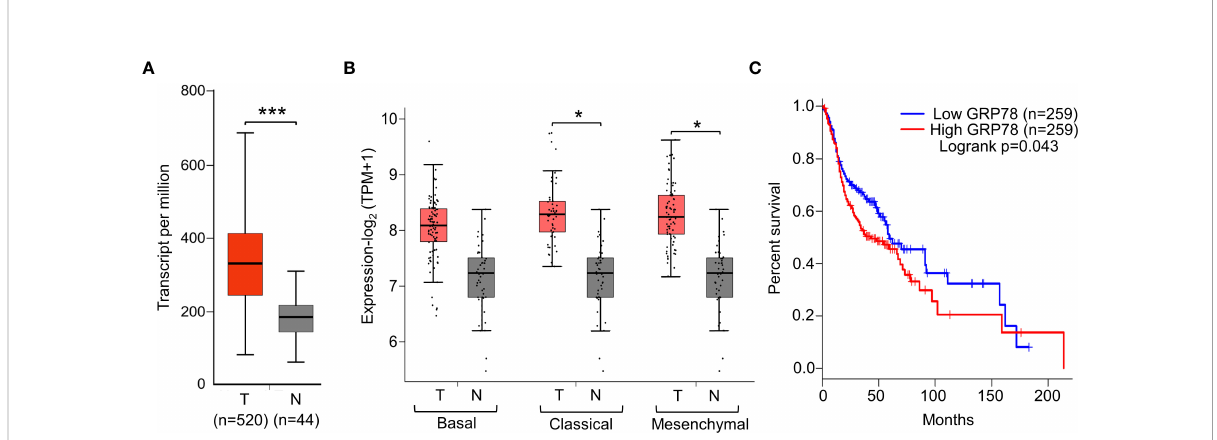
FIGURE 1 Elevated GRP78 expression in HNSCC tissues associates with poor prognosis. (A) Gene expression analysis of GRP78 in HNSCC using UALCAN tool based on the TCGA database. Box plots represent the relative expression of GRP78 in terms of transcript per million in the tumor (red, n=520) and normal (gray, n=44) samples. (B) Gene expression analysis of GRP78 in sub-types of HNSCC using GEPIA2 tool based on the TCGA database. Box plots represent the GRP78 gene expression level in terms of log 2 (TPM+1) in the tumor (red, n=87 for Basal, n=49 for Classical, n=75 for Mesenchymal) and normal (grey, n=44) samples. (C) Kaplan – Meier plot showing the association of GRP78 expression with HNSCC patient survival (blue line — lower expression; red line — higher expression). * P ≤ 0.05, *** P ≤ 0.001 (Student's t